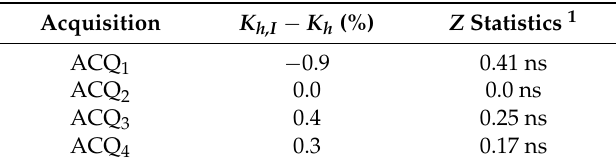
Table 10. Test of differences between overall Kappas derived from classification of trees and non-tree objects in cross validation of logistic regression models based on height and range-normalized intensity (Equation (8)) and height (Equation (7)) as explanatory variables,